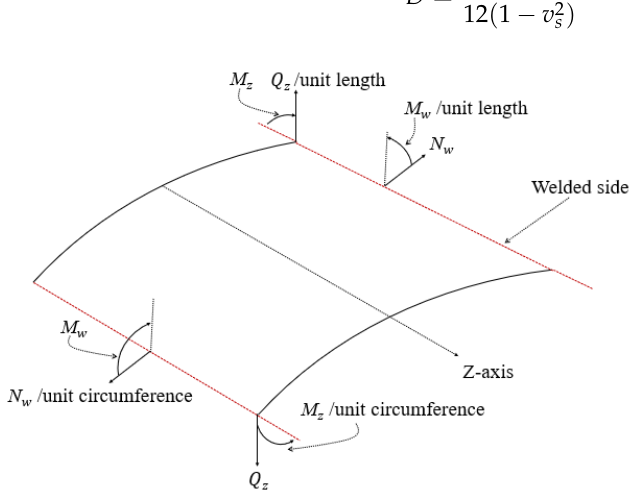
Figure 17. Stress and bending components of Equation